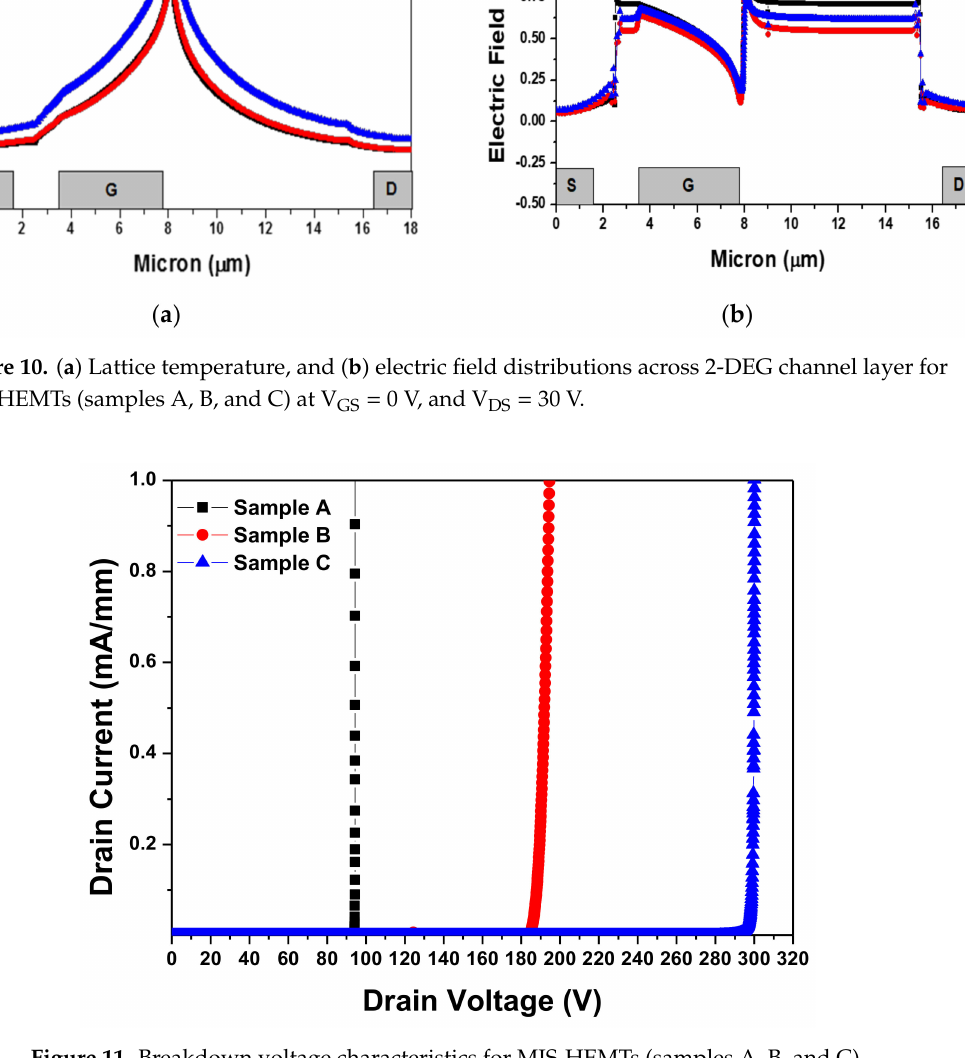
Figure 11. Breakdown voltage characteristics for MIS-HEMTs (samples A, B, and